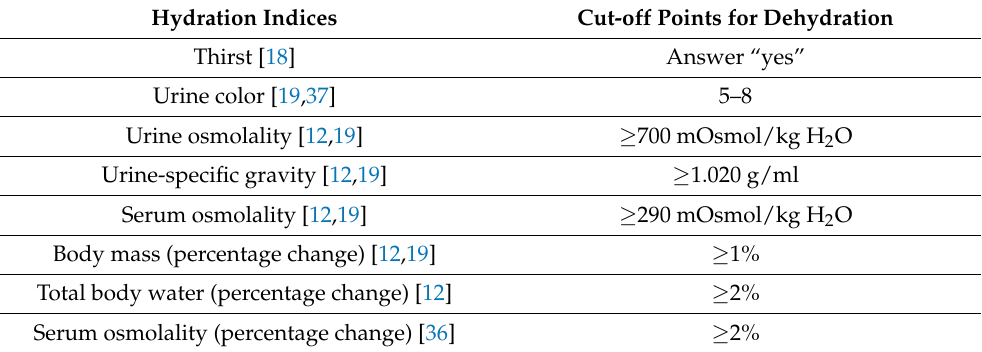
Table 1. Criteria for classification of a dehydrated state